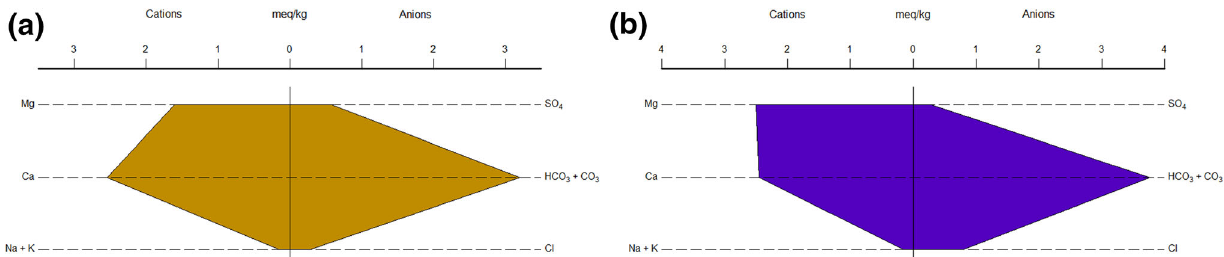
Fig. 3 Stiff diagram of: a Kakareza and b Dehnu hydrometry stations